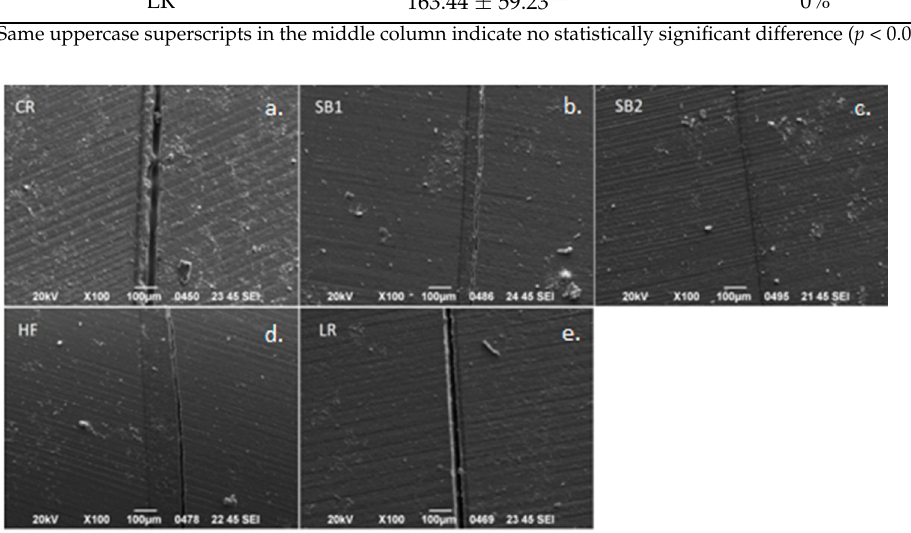
Figure 4. Representative SEM images (×100 magnification) for each experimental group at the ma- terial/dentin interface revealing the microgap formation: ( a ) CR: control; ( b ) SB1: air abrasion with 29 μ m Al 2 O 3 particles; ( c ) SB2: air abrasion with 53 μ m Al 2 O 3 particles; ( d ) HF: hydrofluoric acid gel + silane; ( e ) LR: Er,Cr:YSGG laser treatment.